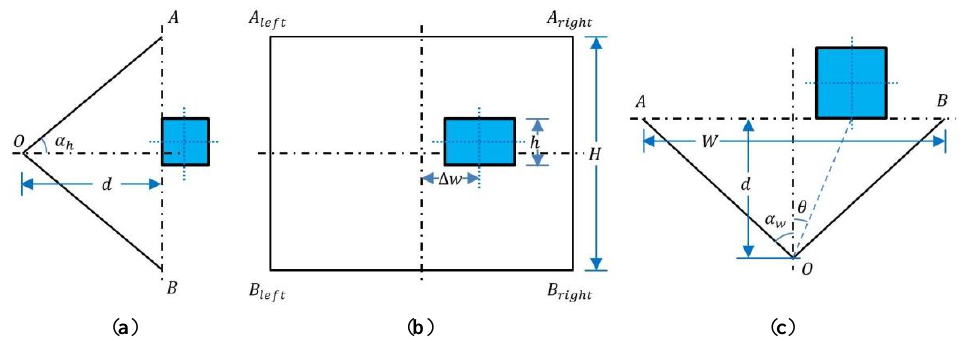
Figure 3. Diagram of the spatial relationship when taking a photo. ( a ): Side view. AB indicates the actual plane where the object is located, α h is half of the maximum lateral field of view angle. ( b ): Front view. Rectangle A left A right B right B left is the imaging region in the actual plane of the object location, h and H are the height of the target and region, respectively. ∆ w indicates the offset distance between the target center and the center of the field of view. ( c ): Top view. W is the width of the imaging region. α w and θ are half of the maximum horizontal field of view and the angle of the target center offset,